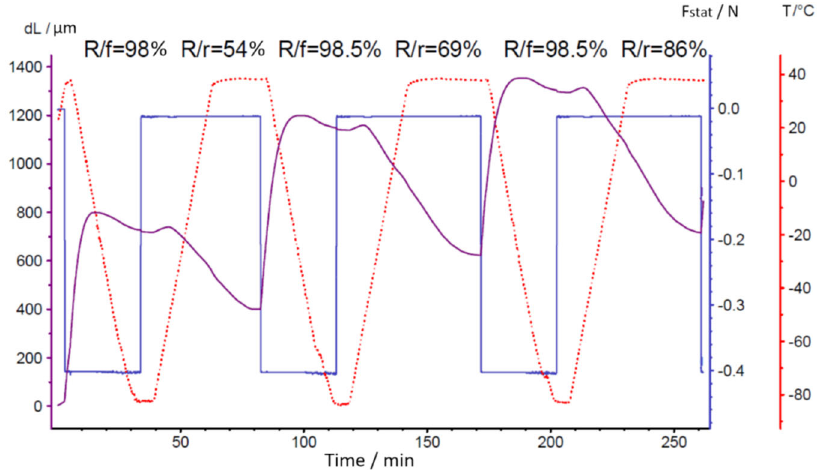
Figure 14. Cyclic thermomechanical tests of S2-segmented PUU in DMA